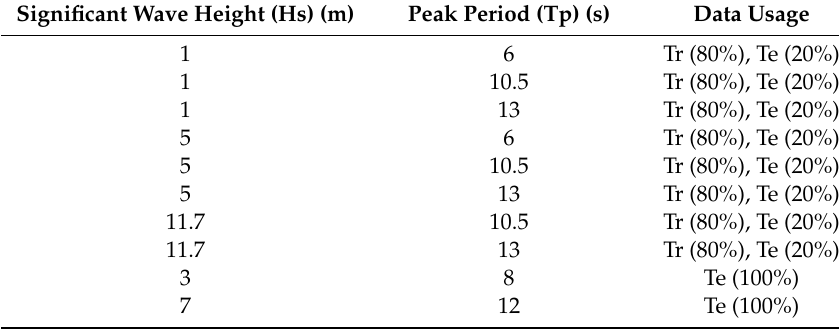
Table 3. Wave conditions (Tr is training, Te is testing, percentage in bracket denotes the percentage of data used for training or testing).